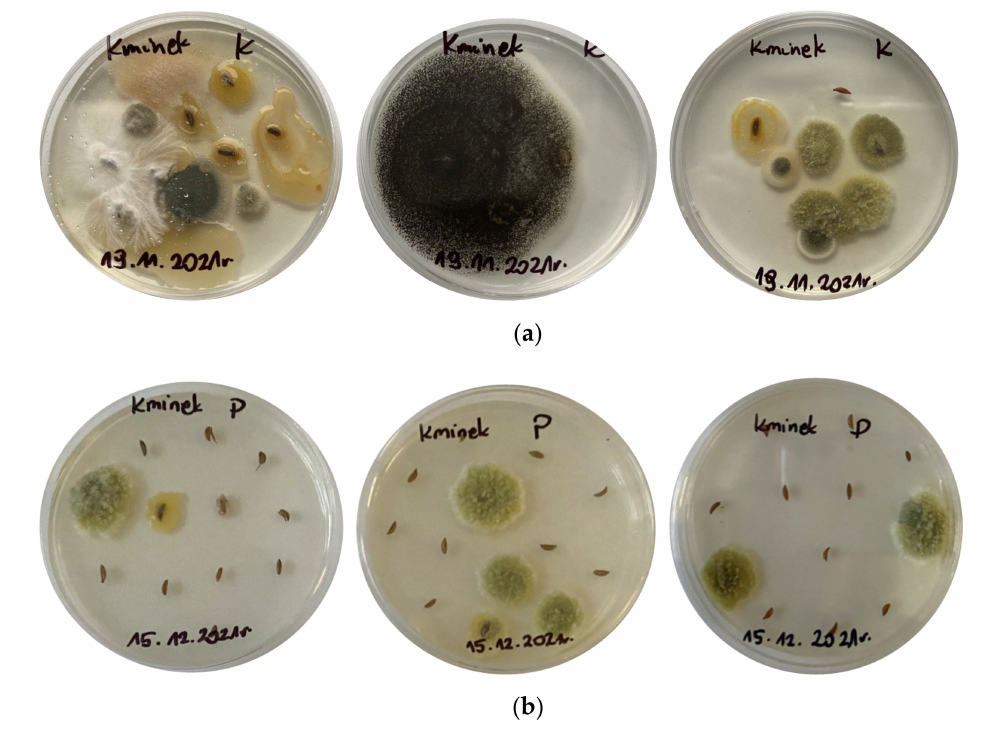
Figure 3. Control (untreated) ( a ) and treatment ( b ) by dielectric barrier discharge plasma (DBD) seeds of caraway ( Carum carvi L.) cultivated on PDA medium. Clear growth inhibition of some pathogenic fungi and bacteria after